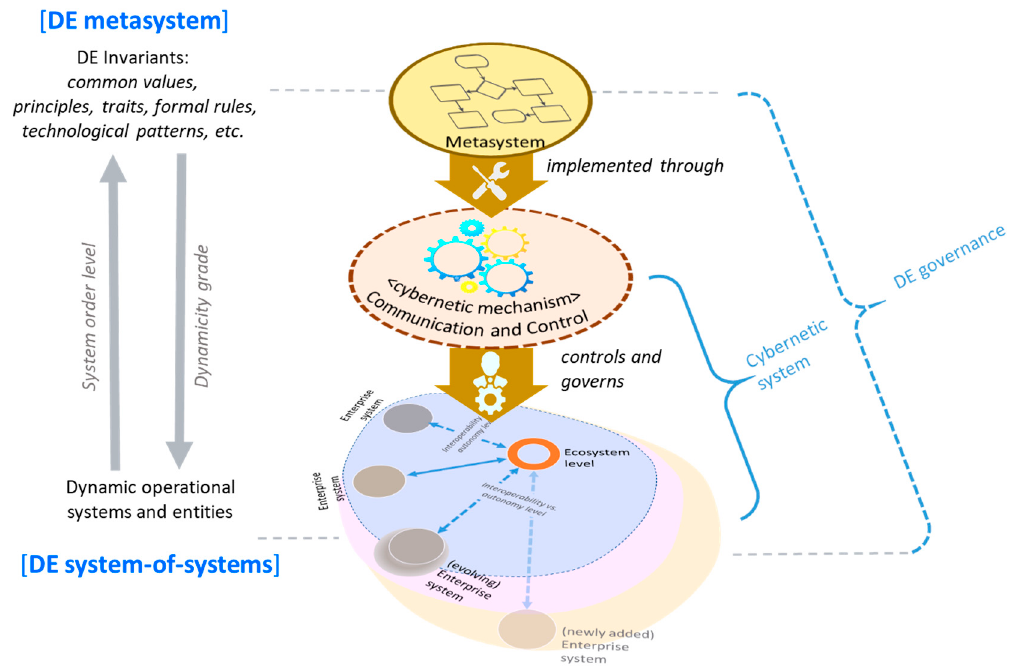
Figure 5. The main (and multi-level) architectural elements implementing a viable DE.